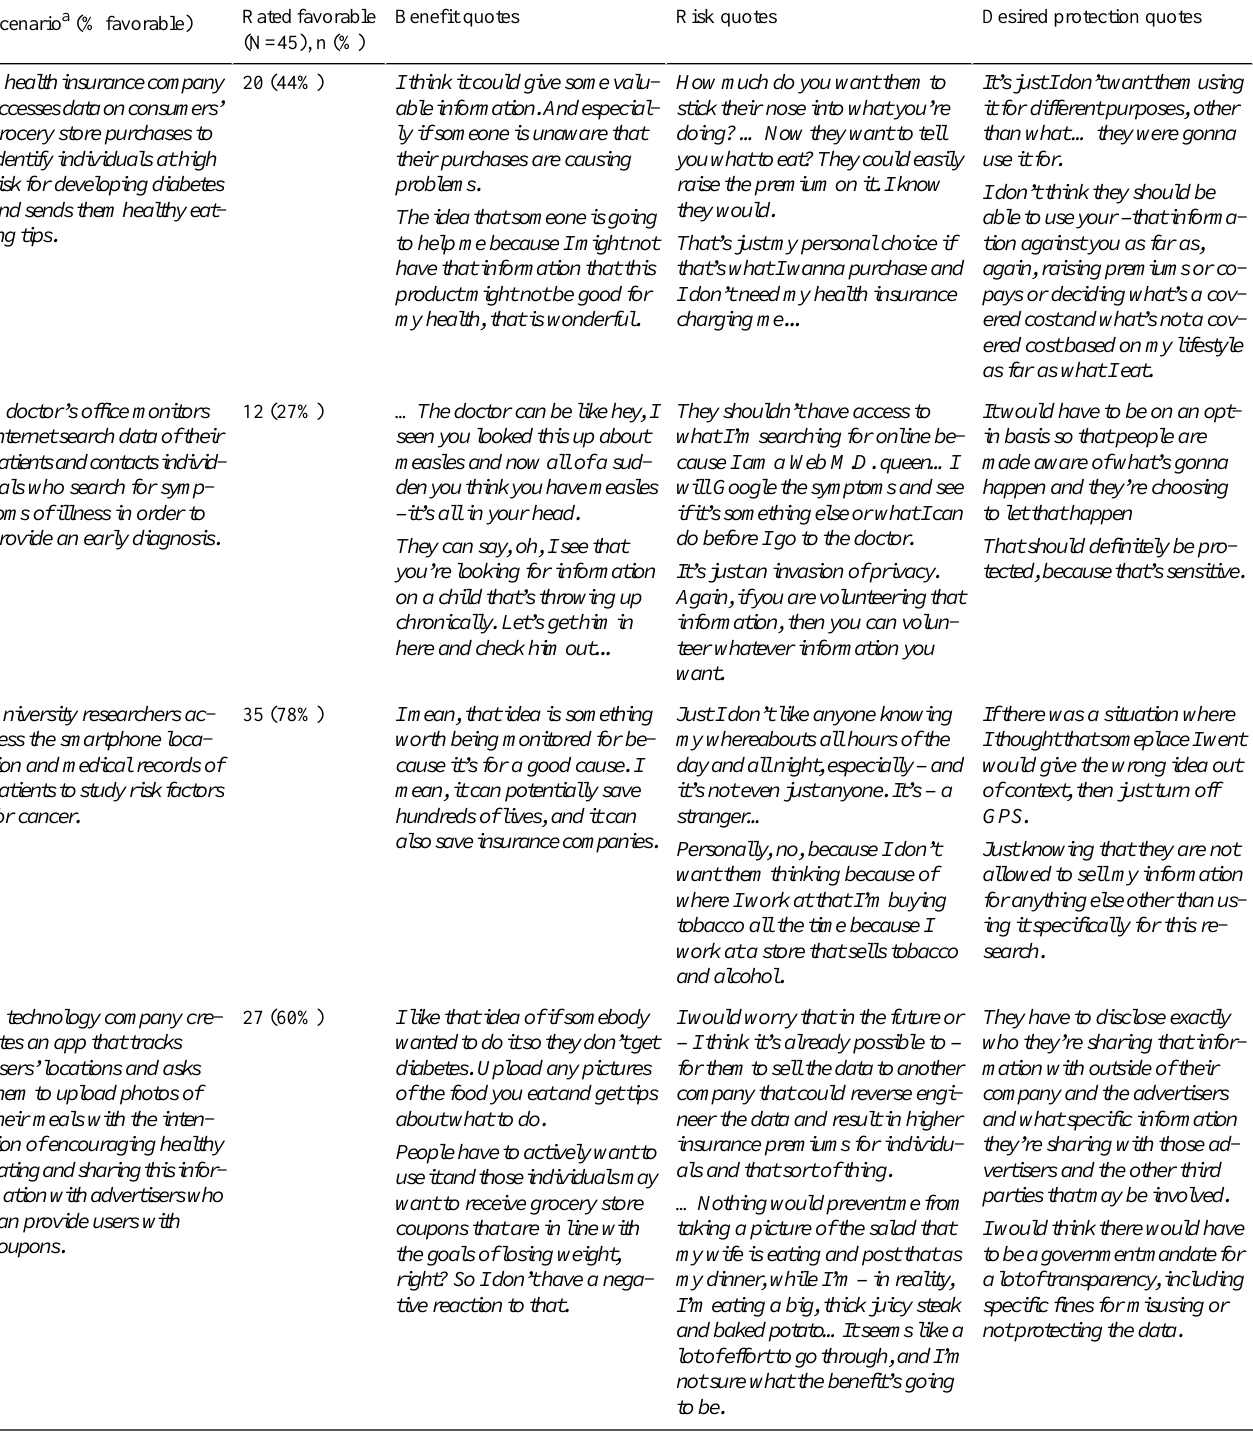
Table 4. Consumer perspectives on digital data use scenarios (illustrative